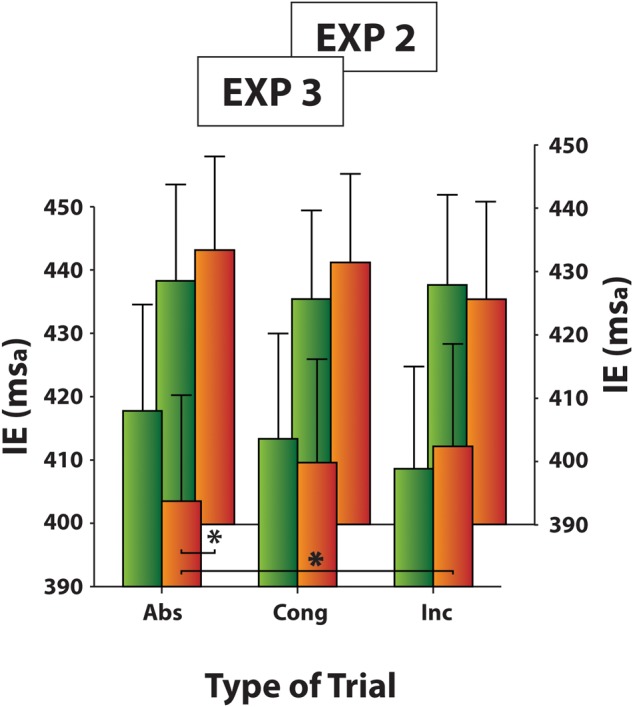
Experiment 3: Mean IE scores of distractor-absent trials in Pure and Mixed blocks (60% Cong block and 60% Inc block). Results of Experiment 2 are also plotted on background for a comparison. Error bars represent the standard error of the means across participants. Asterisks mark significantly different mean/s.